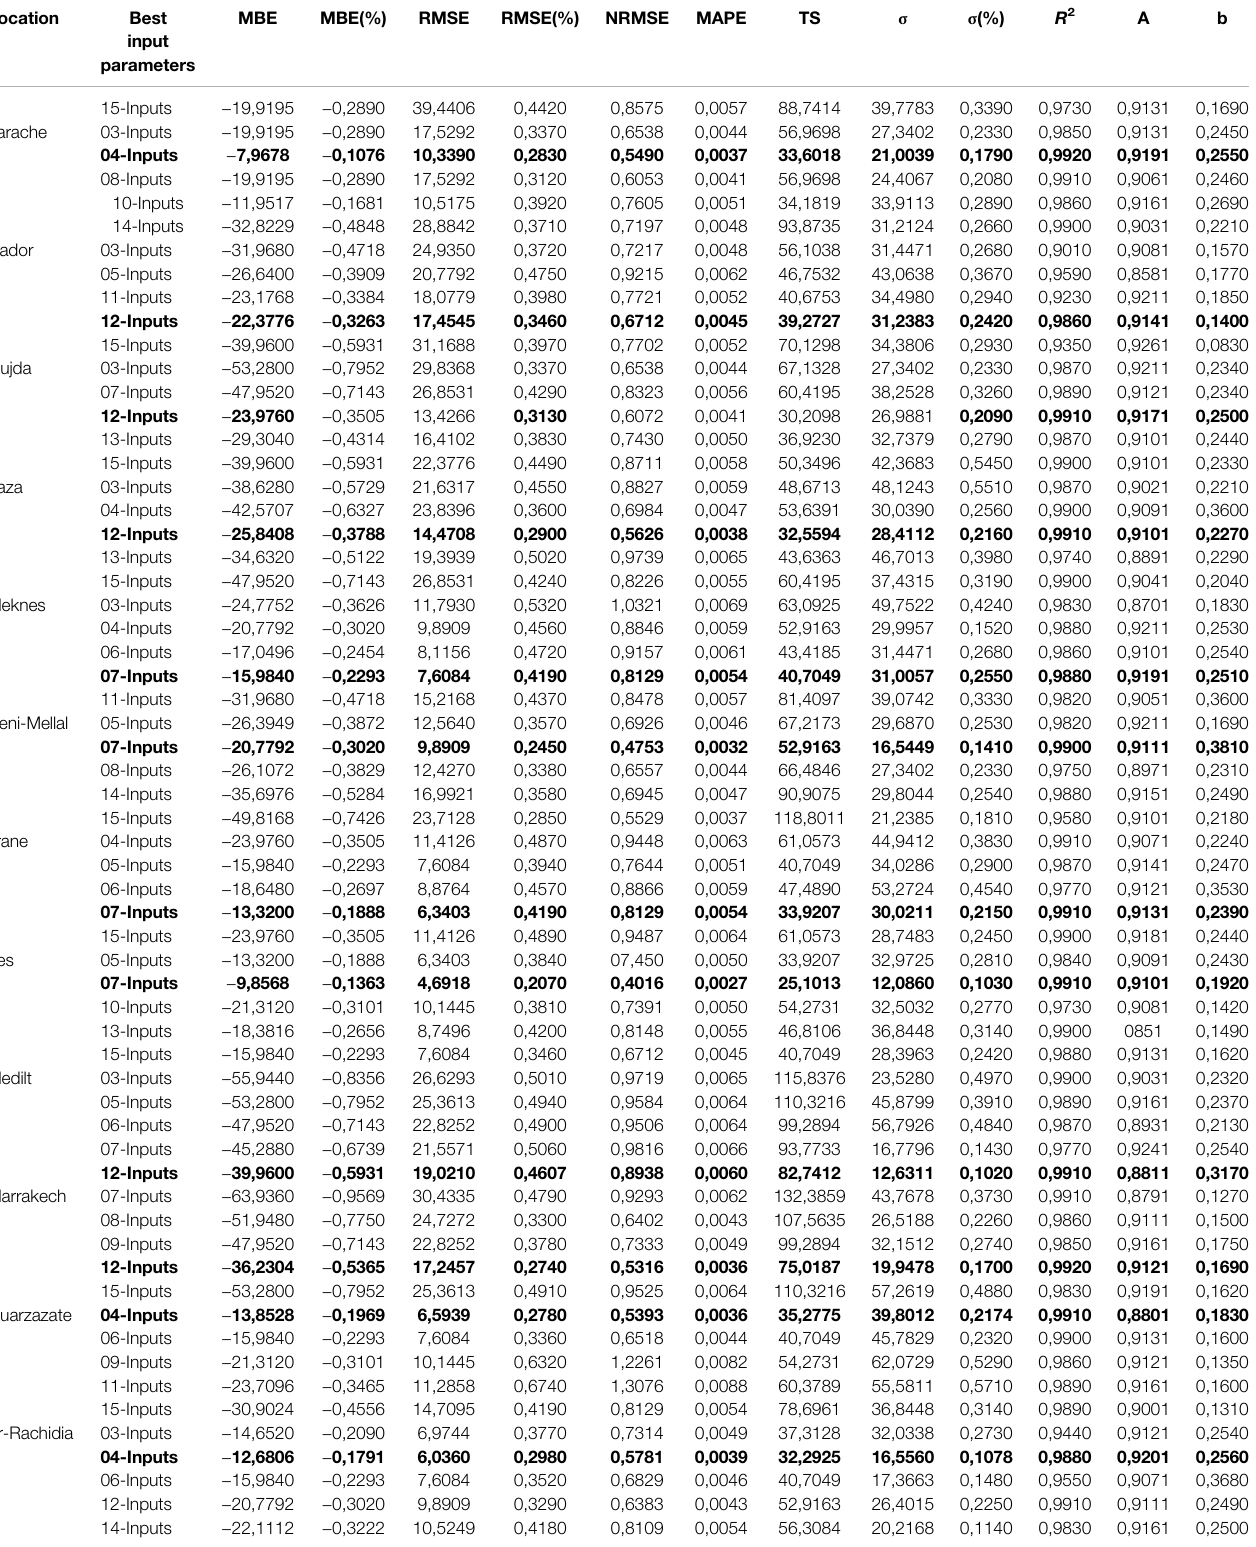
TABLE 5 | ( Continued ) Best fi ve inputs parameters of 25 location in